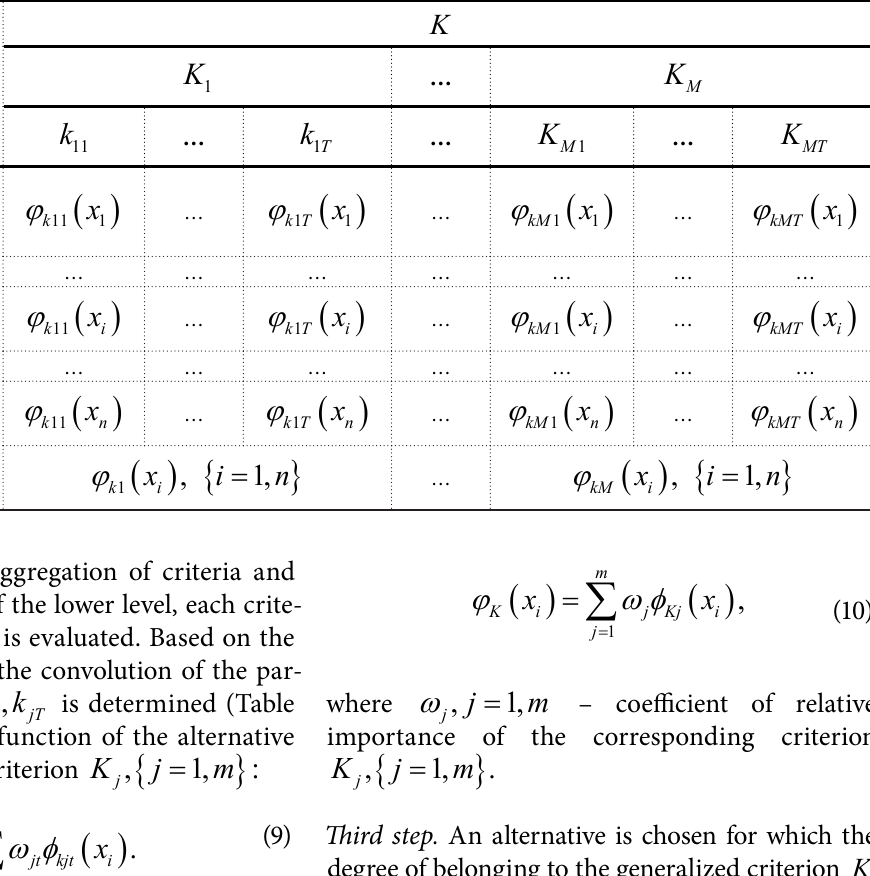
Table 1. Definition of the membership function of alternatives { criteria